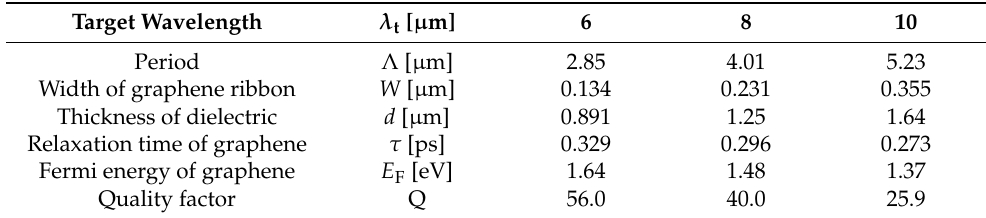
Table 1. Design parameters and obtained quality factors of the graphene ribbon metasurface.